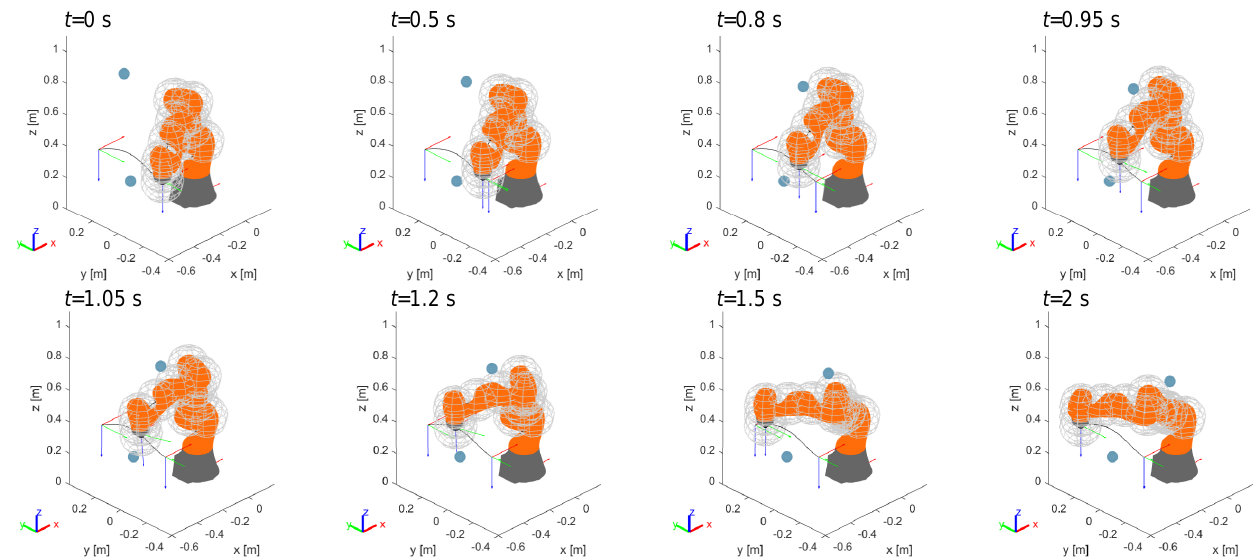
Figure 15. Example 3: avoidance of two obstacles.